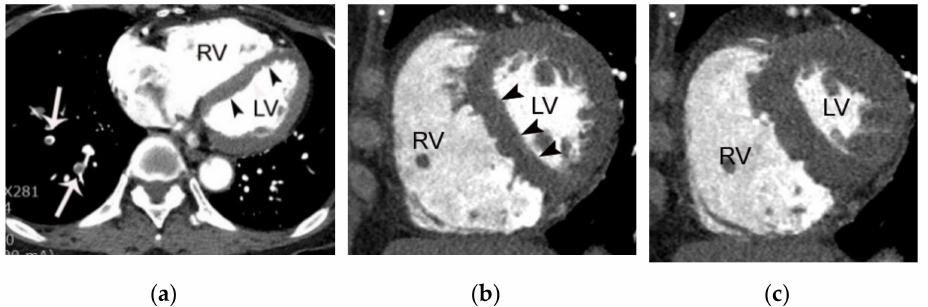
Figure 11. A case of submassive pulmonary embolism in a 66-year-old female patient shown on coronary CTA. ( a ) Multiple pulmonary emboli (arrows) are noted in the right lower lobe on an axial CT image using a wide field of view. Note marked dilatation of the right ventricle and straightening of the interventricular septum (arrowheads) suggesting increased right ventricular pressure. A decrease in the contractile function of the right ventricle can be assessed in this patient due to the use of retrospective ECG gating. Note the lack of change in the right ventricular volume between the diastolic ( b ) and systolic ( c ) short-axis images indicating right ventricular dysfunction. RV and LV indicate right and left ventricle, respectively.